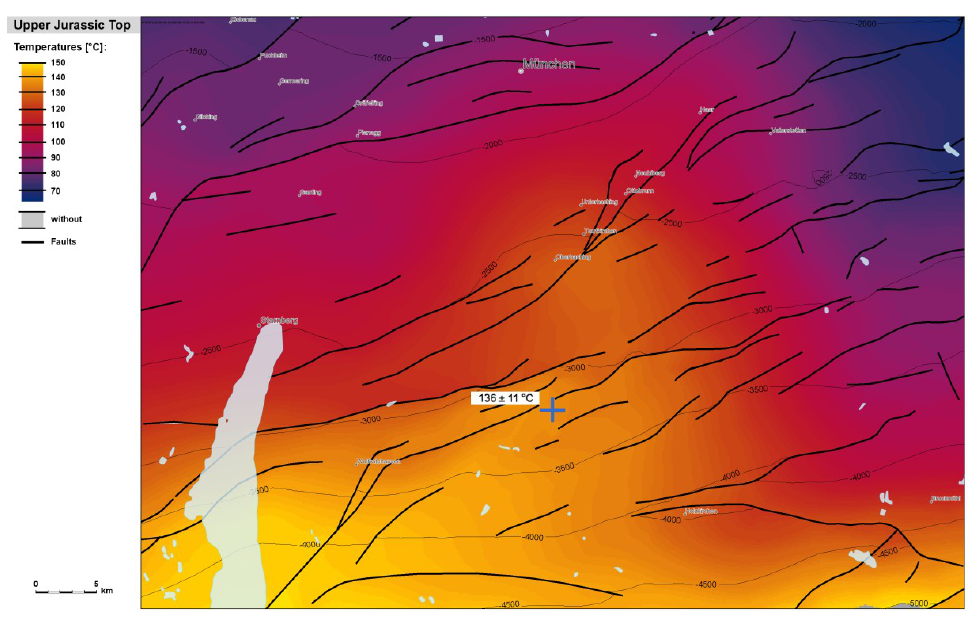
Figure 5. Screenshot of GeotIS with a map of the subsurface temperature at the top of the Upper Jurassic formation (Malm) south of Munich (Bavaria). Bold black lines mark the location of faults in the Molasse Basin. The temperature scale adjusts automatically to the existing range of values in the selected area. A mouse-over-feature gives temperature values or the name of a well (not shown in this example). The superimposition of temperature, depth contours, fault lines and topographic features simplifies the first assessment of potential geothermal project